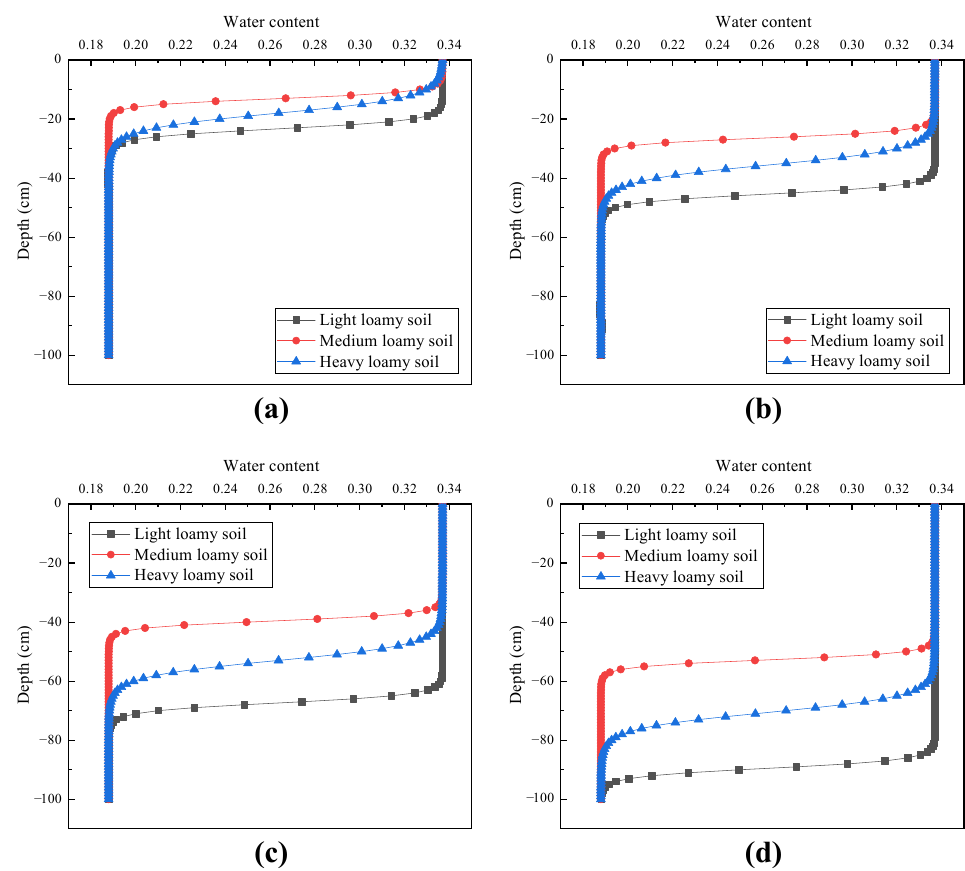
Figure 14. Comparison of water infiltration profiles of different soil types at the same time, ( a ) is the comparison of water infiltration profiles of different soil types at 10 min, ( b ) is the comparison of water infiltration profiles of different soil types at 20 min, ( c ) is the comparison of water infiltration profiles of different soil types at 30 min, ( d ) is the comparison of water infiltration profiles of different soil types at 40